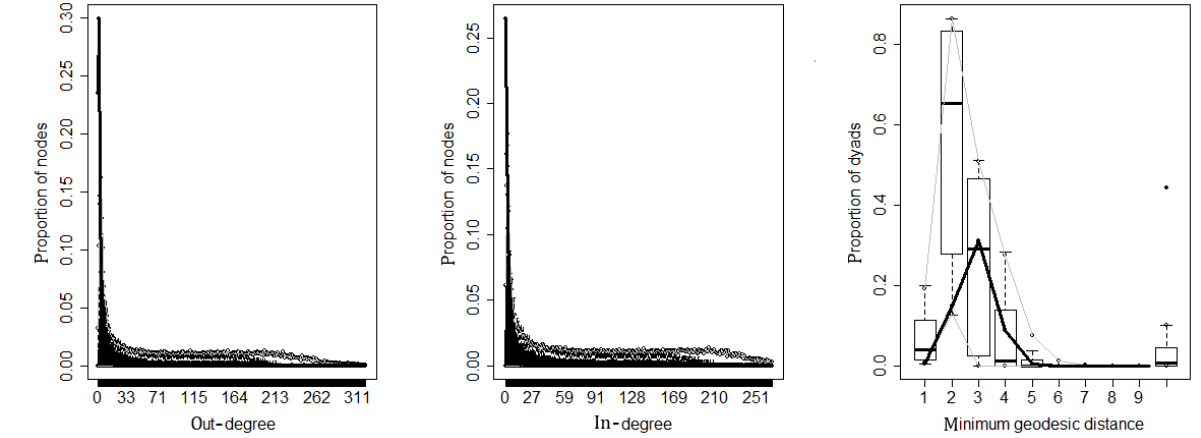
Figure 4. Goodness of fit for measures from simulated informational support